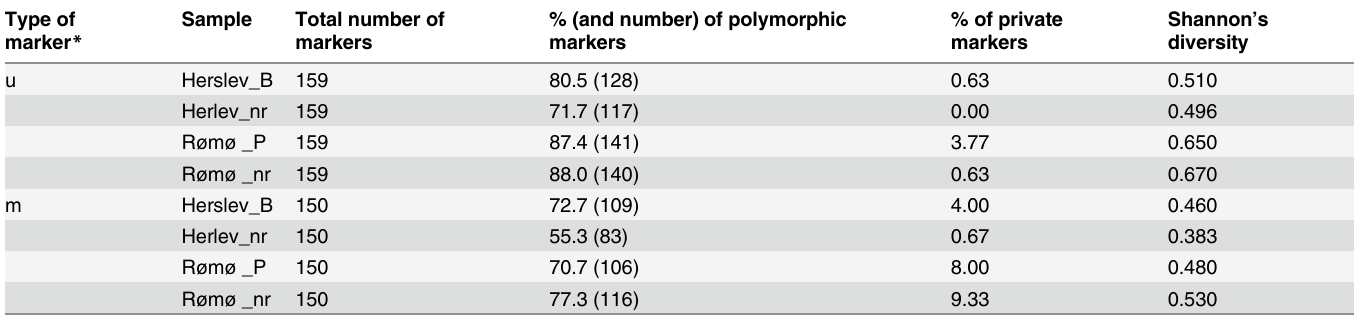
Table 3. Epigenetic diversity in the samples (using Mixed scoring 2 [28]).